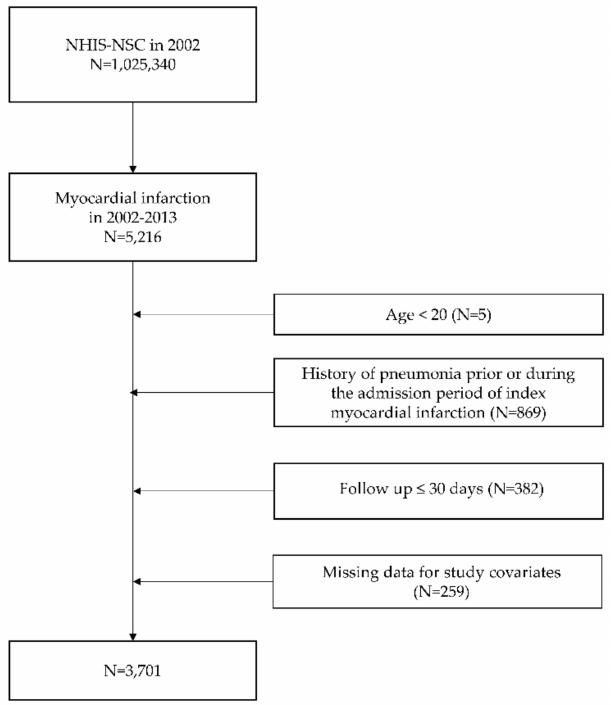
Figure 1. Flowchart of included patients. NHIS-NSC, National Health Insurance Service national sample